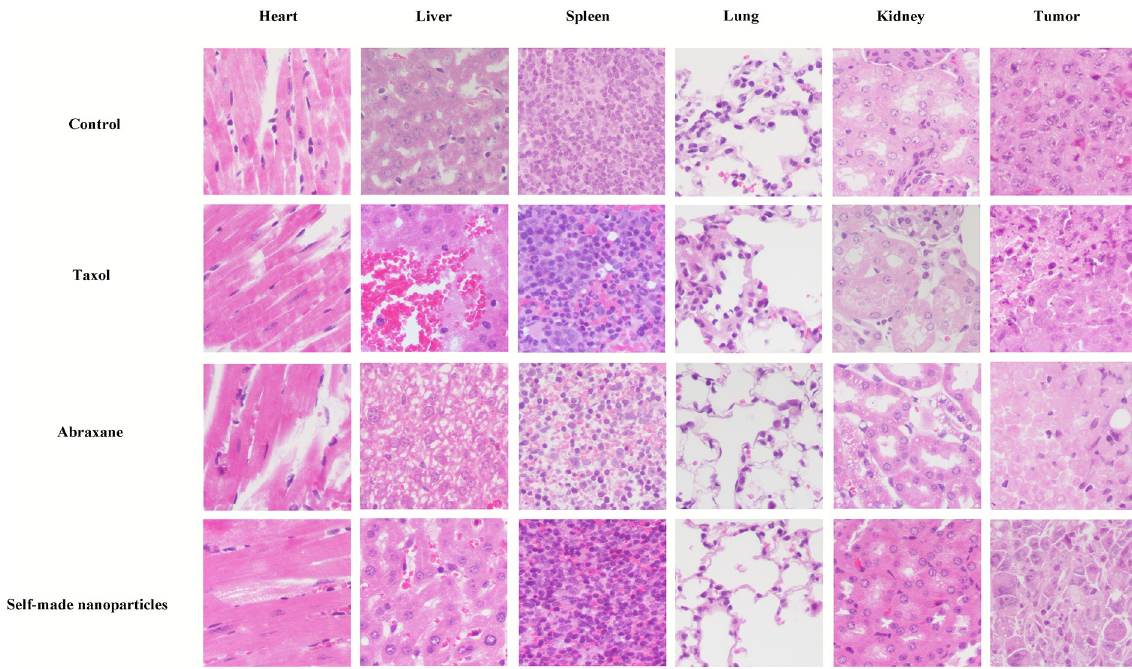
Fig 10. Photographs of primary organs and tumor tissues stained with H&E from mice treated with physiological saline, Taxol, Abraxane, and self-made nanoparticles at the dose of 10mg/kg (20 × ).